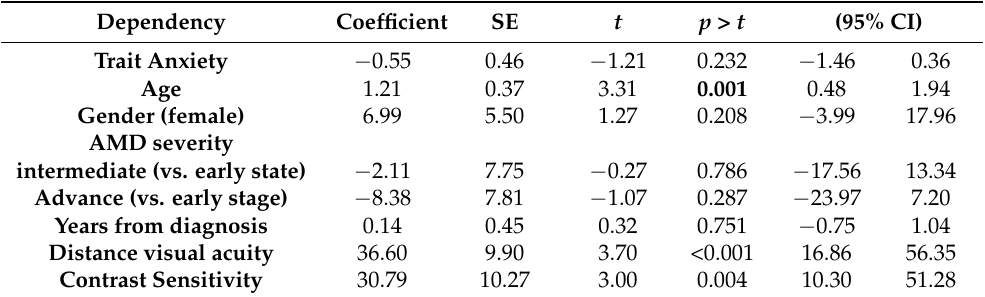
Table 8. Multiple linear regression model that correlates trait anxiety with the subscale Role Difficul- ties from the quality-of-life questionnaire NEI-VFQ-25.